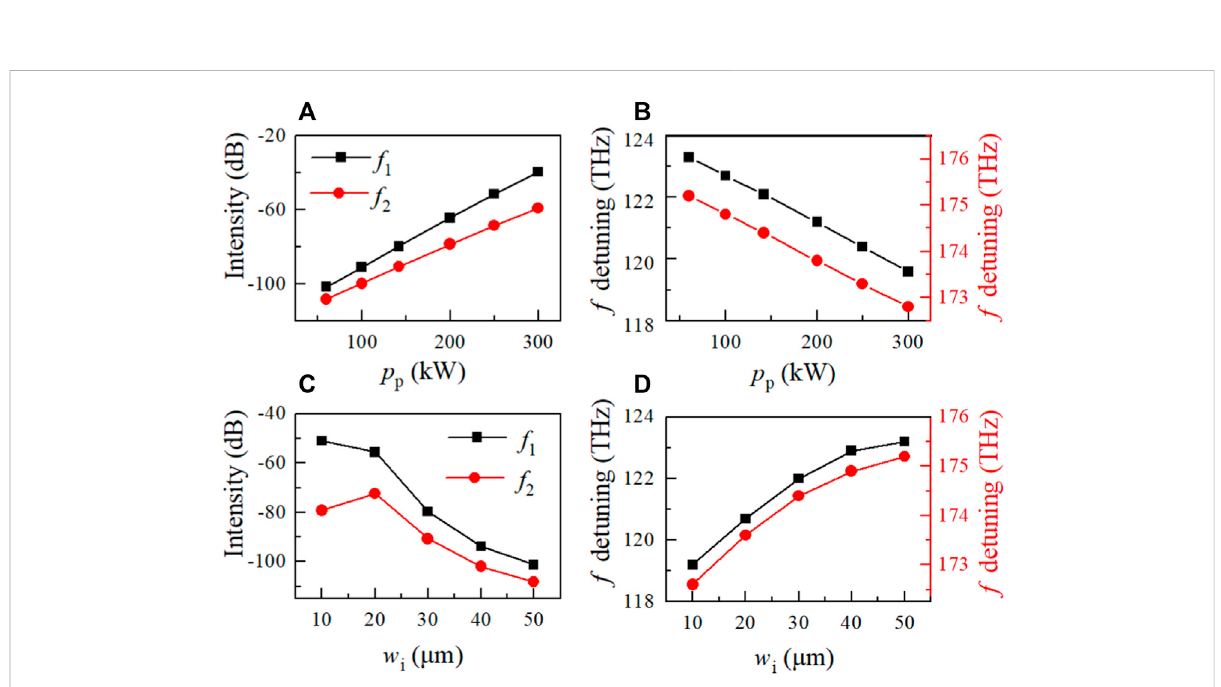
FIGURE 5 (Coloronline)Dependencesoftheintensityandfrequencydetuningofthe fi rstandsecondsidebandcenter f 1 and f 2 atadistance z (cid:2) 30 mm on (A and B) thepeak power P p with w i (cid:2) 30 μ m and (C and D) the spotsize w i with P P (cid:2) 142kW. Here, theotherparameters are thesame as inFigure